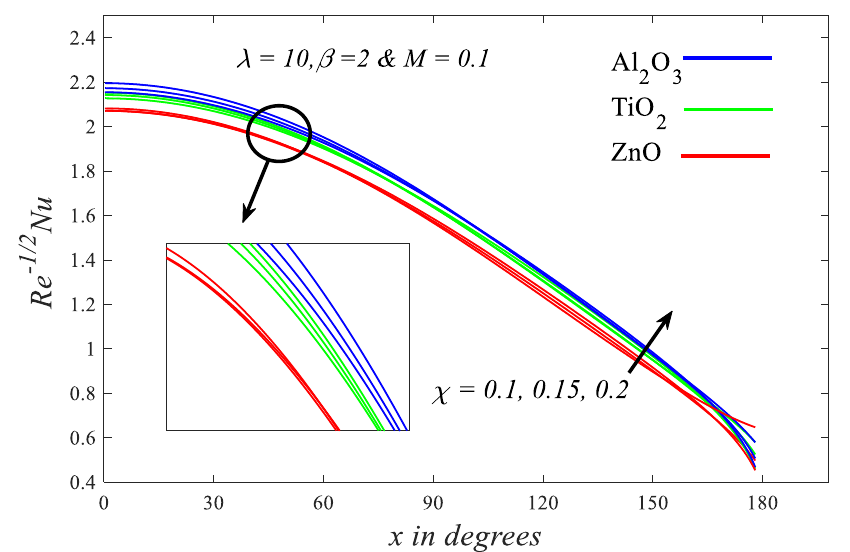
Figure 4. Impression of χ on Re − 1/2 Nu . The inset is a partial enlargement of the curves.